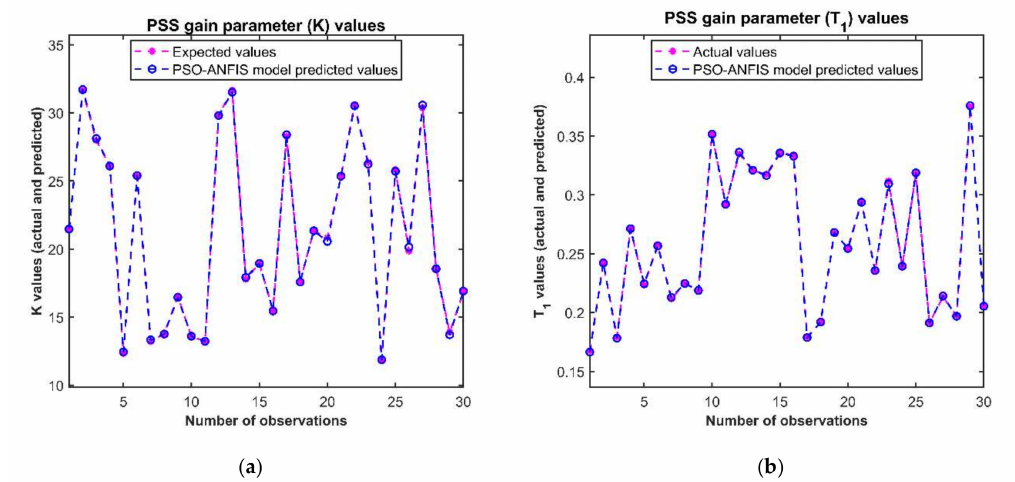
Figure 8. Comparisons of the actual and the PSO-ANFIS models predicted PSS key parameters values for randomly selected 30 samples from the first network test datasets; ( a ) PSS gain parameter ( K ) and ( b ) PSS time constant parameter ( T 1 ).